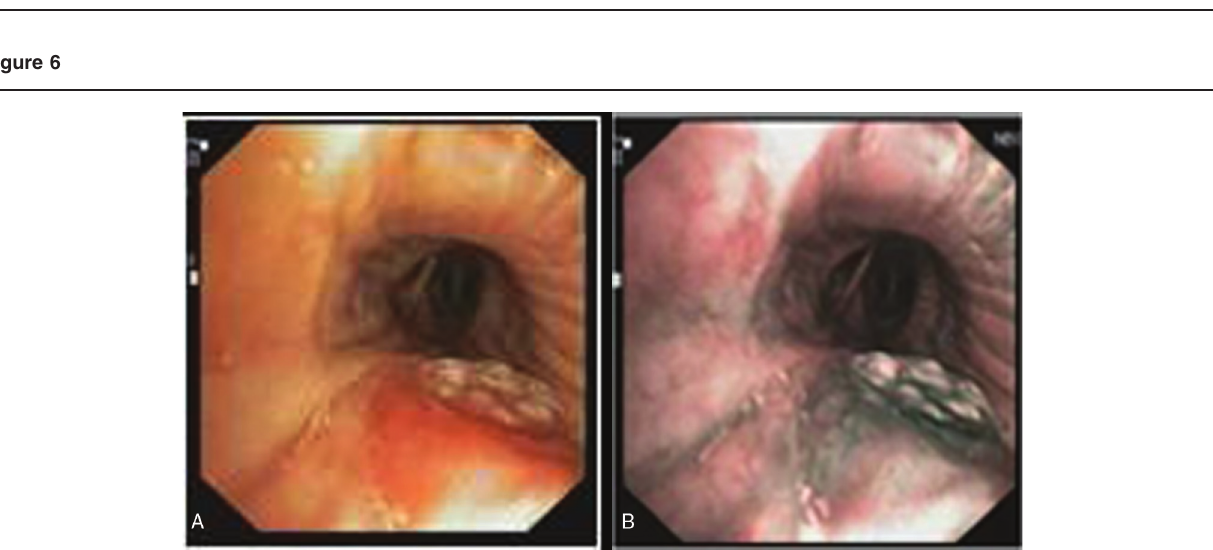
Among the 18 apparently normal patients by WLB, eight showed positive histopathologies by NBI samples; that is eight false-negative cases (Table